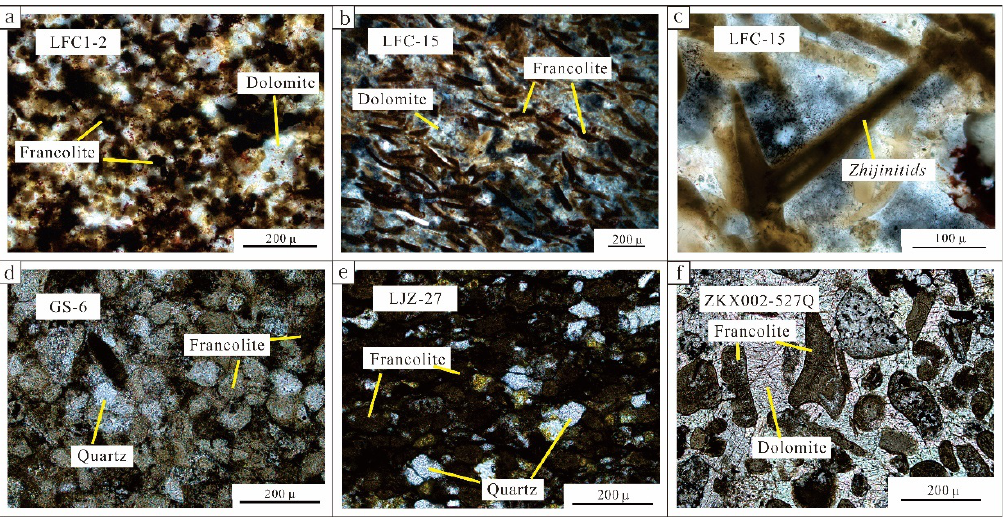
Figure 3. Microstructure of phosphorites in the Zhijin region (under transmitted light, plane polar- ized). ( a ) Granular francolite from the LFC section; ( b ) bioclastic francolite from the LFC section; ( c ) Zhijinitids from the LFC section; ( d ) granular francolite from the GS section; ( e ) granular francolite from the LJZ section; ( f ) bioclastic and granular francolite from the ZKX002 section.